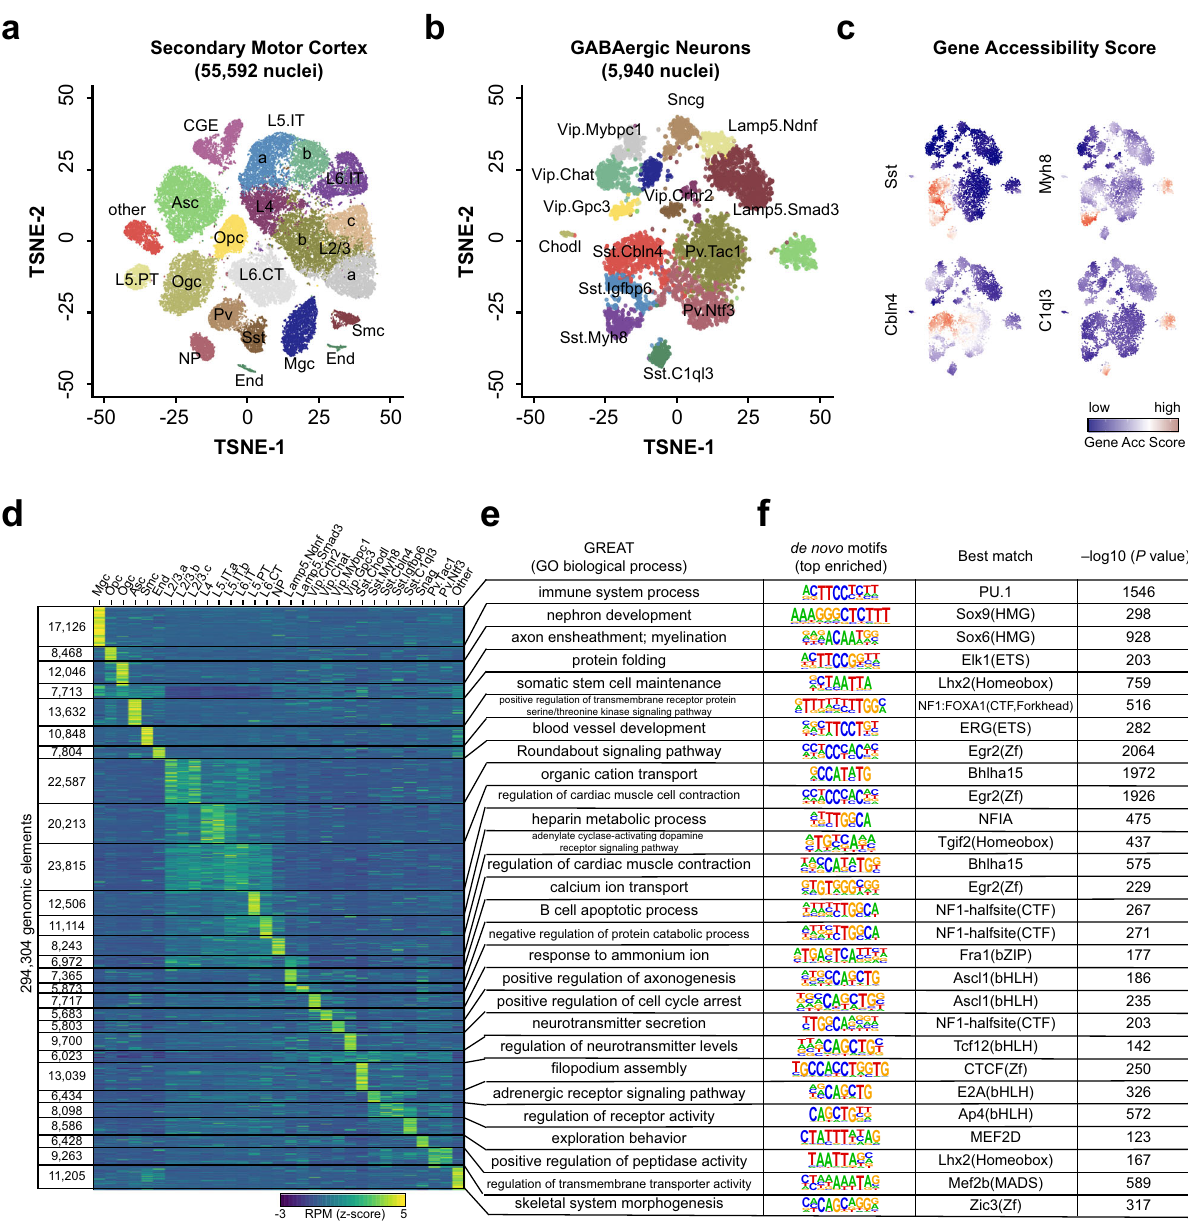
A key utility of single-cell chromatin accessibility analysis is to identify regulatory sequences in the genome. By pooling reads from nuclei in each major cluster (Fig. 5a), cell-type-speci fi c chromatin landscapes can be obtained (Supplementary Fig. 22 and Methods section). Peaks are determined in each cell type, resulting in a total of 373,583 unique candidate cis -regulatory elements. Most notably, 56% (212,730/373,583) of these open chromatin regions cannot be detected from bulk ATAC-seq data of the same brain region (Methods section). The validity of these additional open chromatin regions identi fi ed from scATAC-seq data are supported by several lines of evidence. First, these open chromatin regions are only accessible in minor cell populations